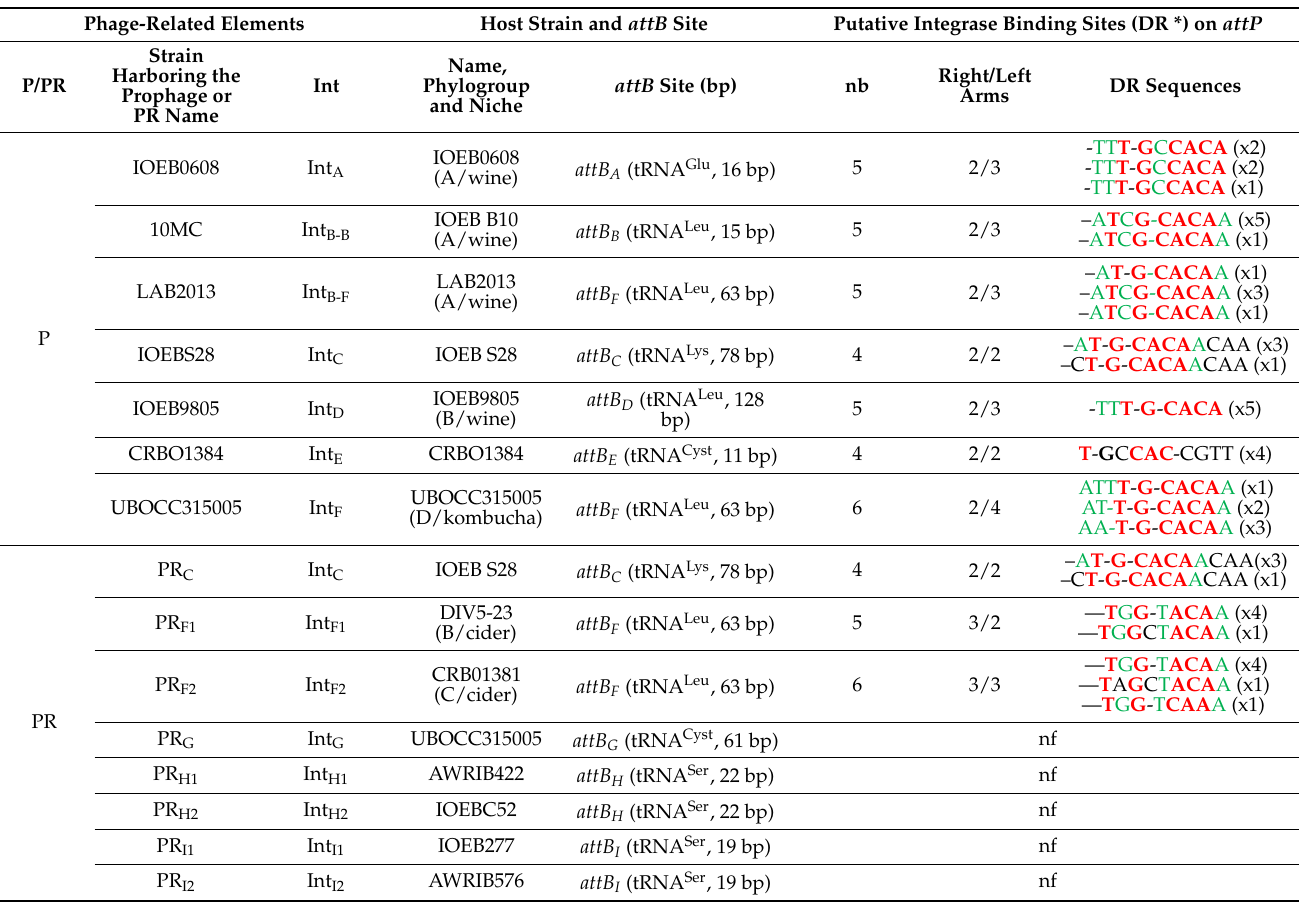
Table 3. Characteristics of the attB and attP regions from oenophages and phage remnants. Phage-Related Elements Host Strain and attB Site Putative Integrase Binding Sites (DR *) on